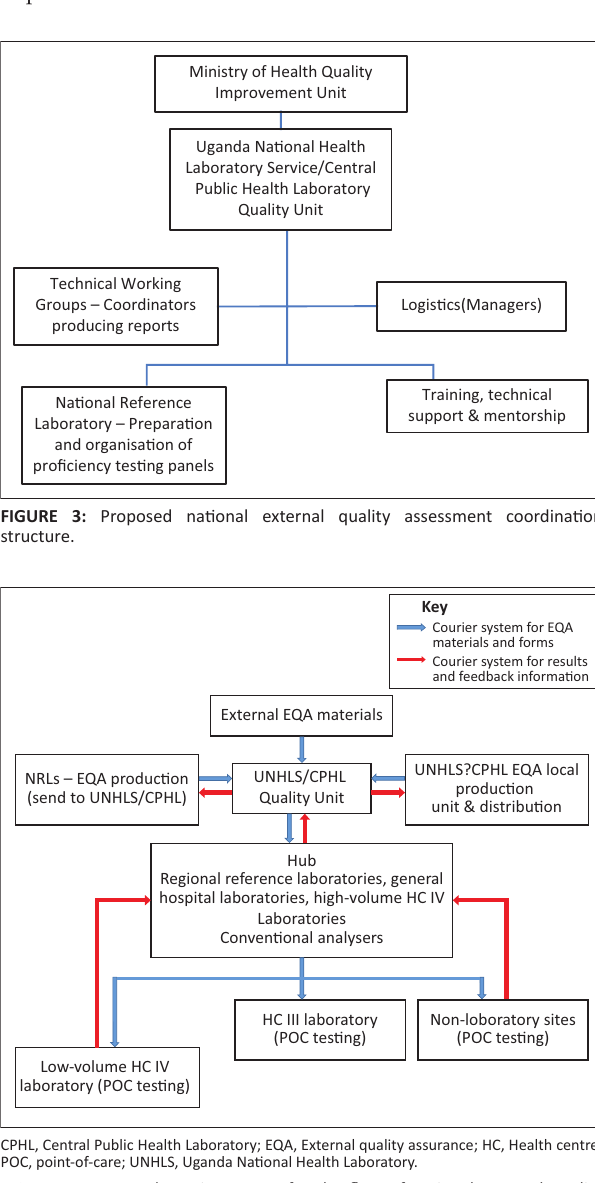
FIGURE 4: Proposed courier system for the flow of national external quality assessment materials, forms, results and